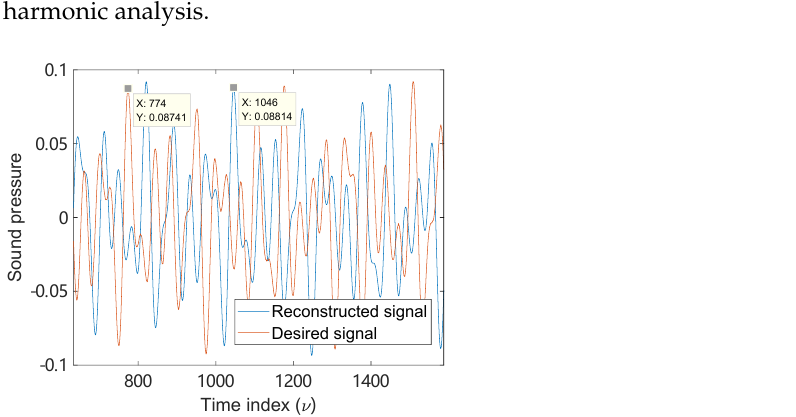
Figure 11. Delay analysis between the desired signal and the reconstructed signal at a point inside the region of